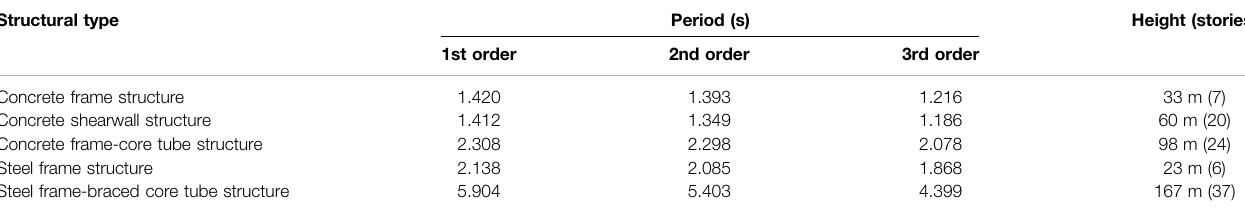
TABLE 1 | Dynamic characteristics of typical